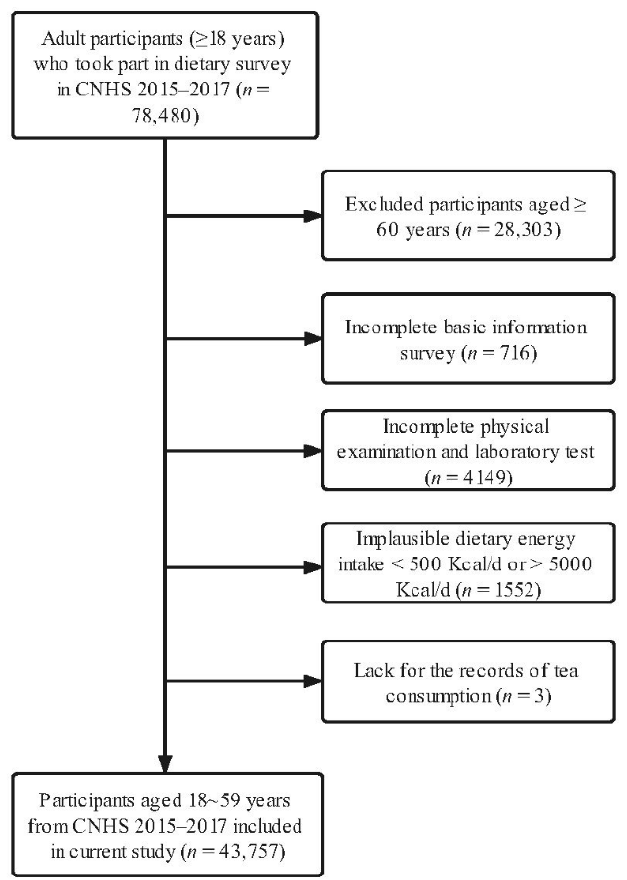
Figure 1. Enrolling process of participants from CNHS 2015–2017.